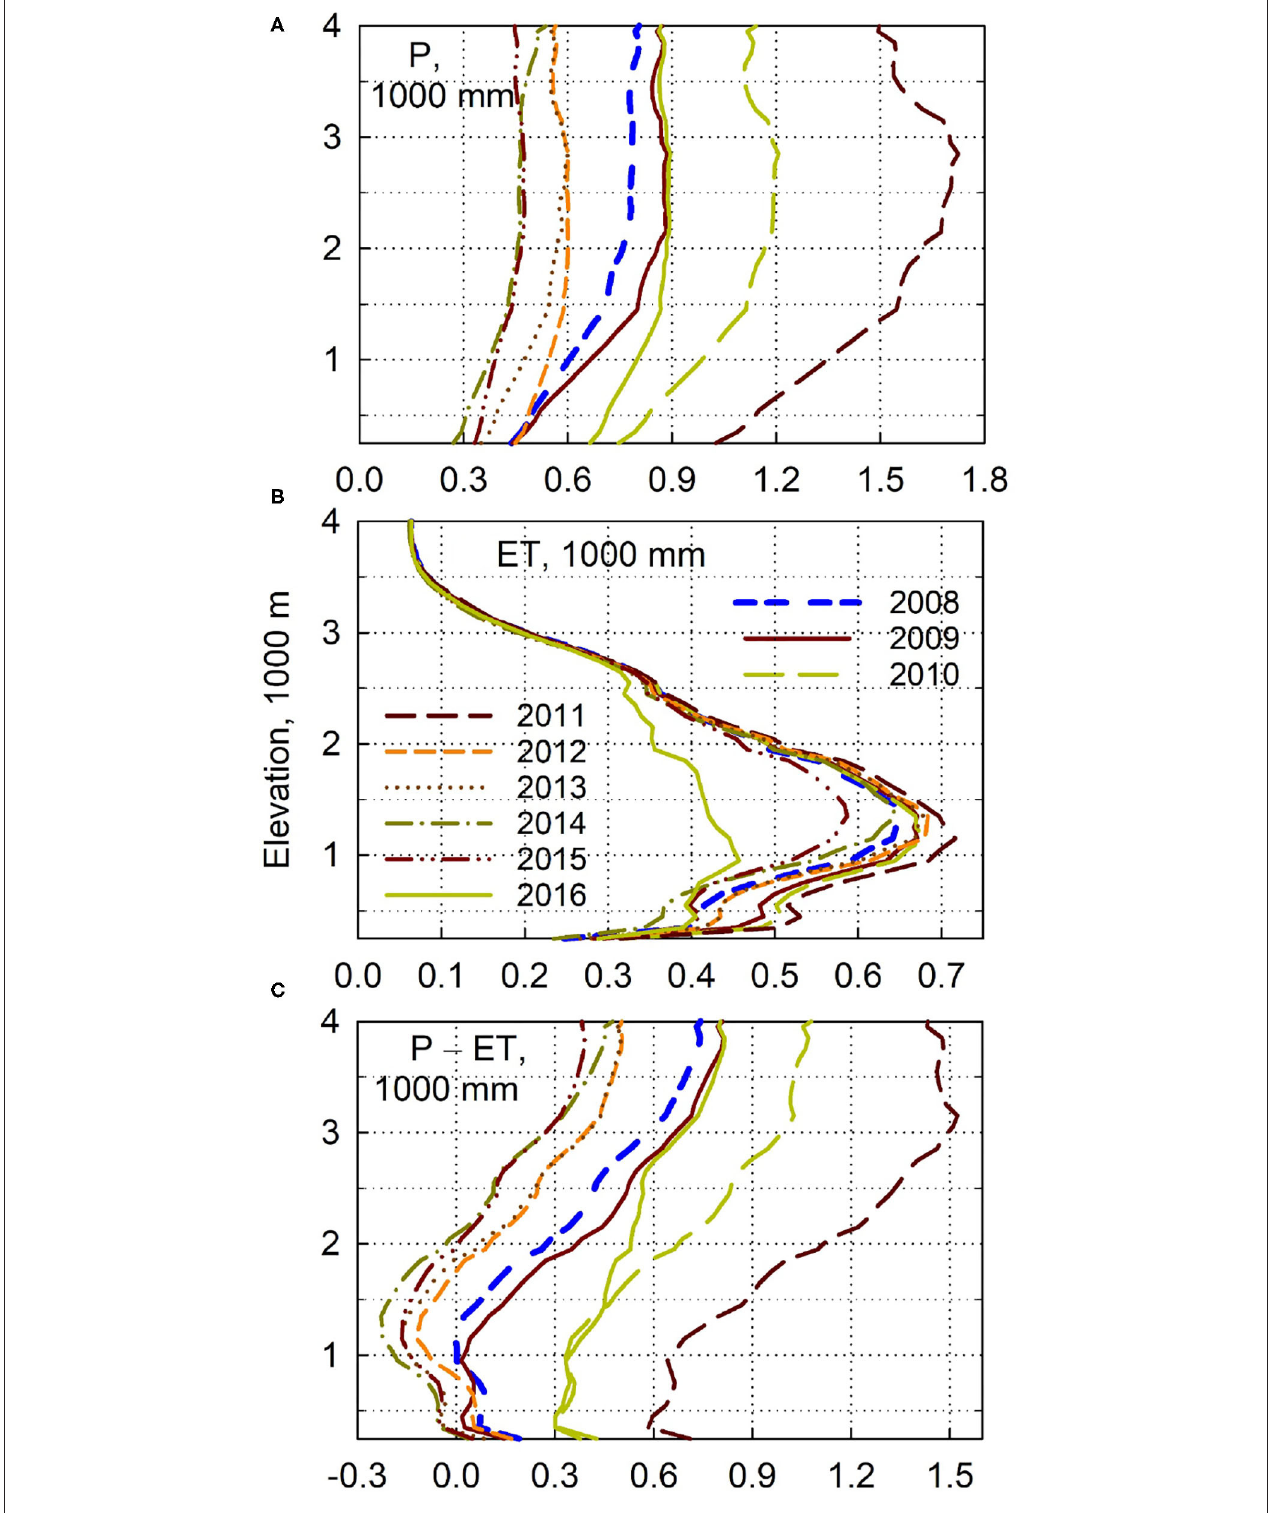
FIGURE 3 | Elevation profiles of annual (A) precipitation ( P ), (B) evapotranspiration ( ET ), and (C) P – ET by water year for the Kings River basin. Adapted from Bales et al. (2018b).